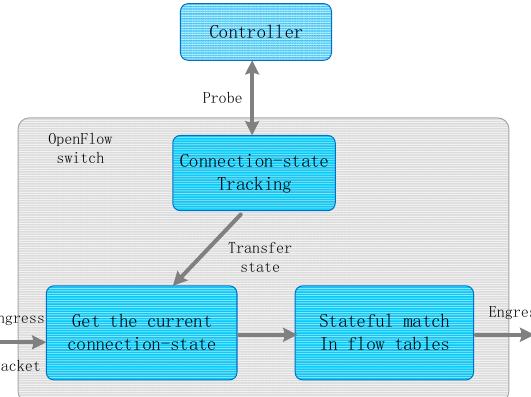
Figure 2. The connection-state processing mechanism. This mechanism uses a dynamic probe to track the connection-state and then transfers the real-time state to the incoming packet. The packet depends on the current state to execute an appropriate stateful match.